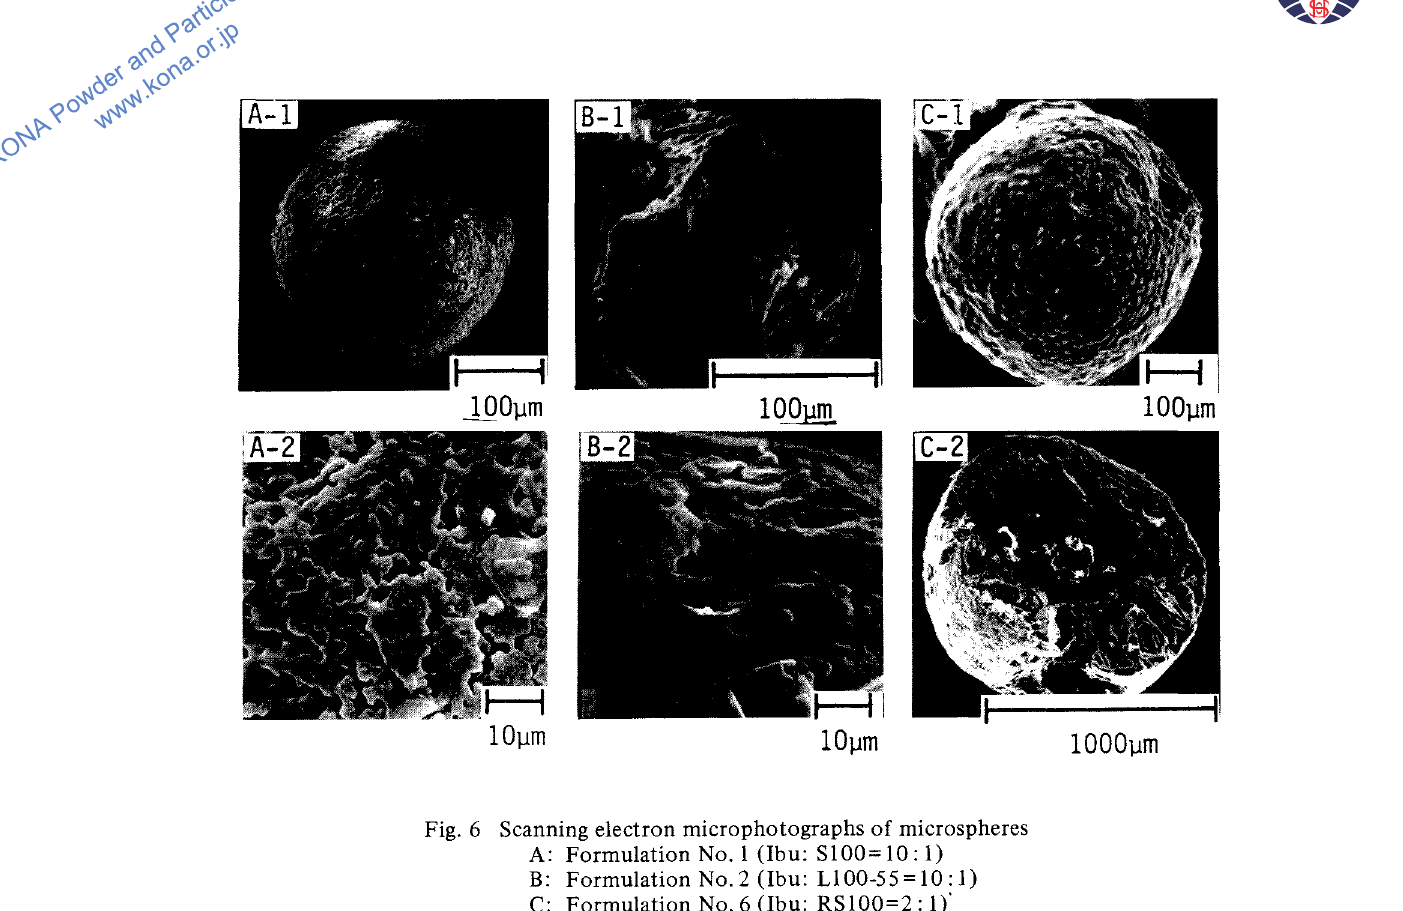
Fig. 6 Scanning electron microphotographs of microspheres